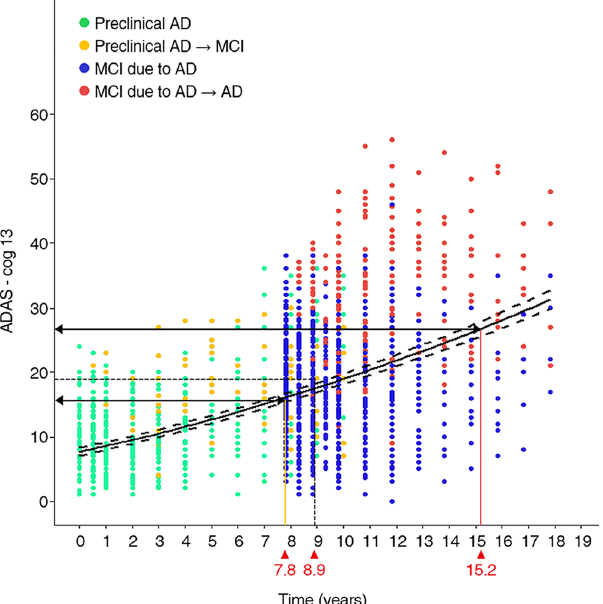
Figure 3. Disease progression model from preclinical AD to AD dementia. The curves present the estimated model—ADAS-cog 13 = (2.8492 + 0.0130 × month) 2 – 0.5 and its 95% CI and the plots show preclinical AD (green dots), progression to MCI due to AD (yellow dots), MCI due to AD (blue dots), and progression to AD dementia (red dots). Using the median ADAS-cog 13 scores at the time of progression for individuals who progressed from preclinical AD to MCI due to AD (16.0 points) and from MCI due to AD to AD dementia (26.8 points), we estimated the time for preclinical AD to progress to MCI due to AD (7.8 years) and to AD dementia (15.2 years). When using the median ADAS-cog 13 scores for late MCI (19.0 points) to estimate time to progression, it took 8.9 years for preclinical AD to progress to late MCI. ADAS-cog: Alzheimer’s Disease Assessment Scale-cognitive subscale; MCI: mild cognitive impairment; AD : Alzheimer’s Disease; CI: Confidence